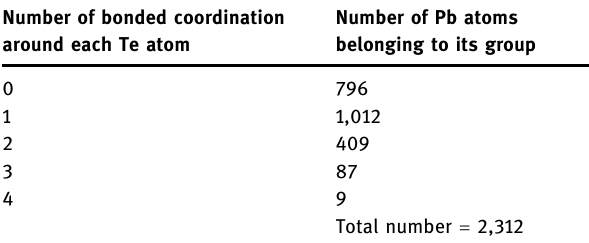
Table 1: Number of bonded coordination around each Te